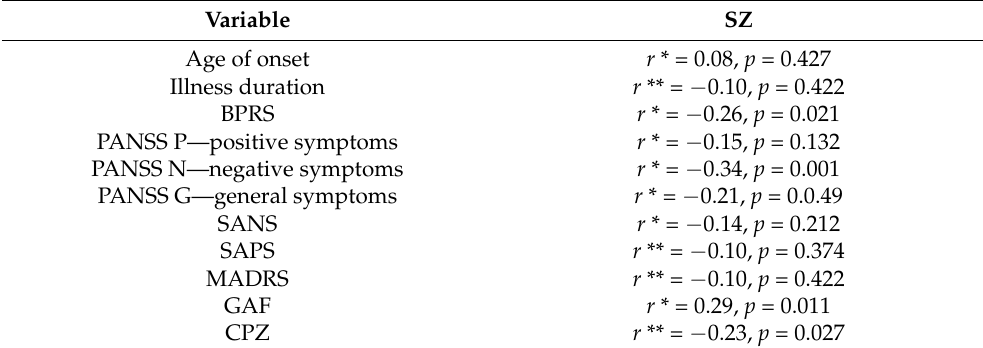
Table A3. Correlational analysis between neurocognitive functioning and clinical